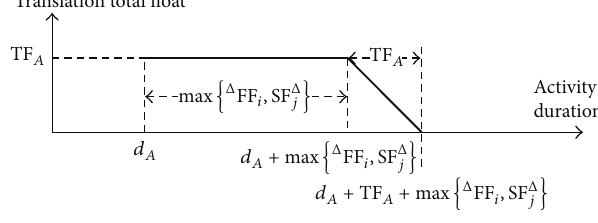
Figure 6: Curve chart of the translation total float of the activity 𝐴 when Δ FF 𝑖 or SF Δ 𝑗 (but not both) is equal to 0.